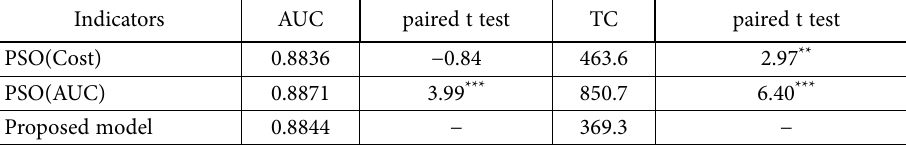
Table 7. Experimental results of performance